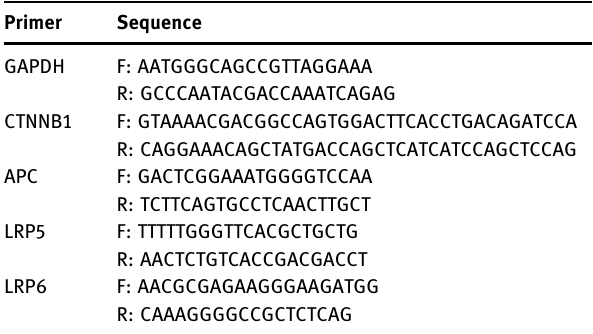
Table 1: Primer sequence used for relative mRNA expression levels Primer Sequence